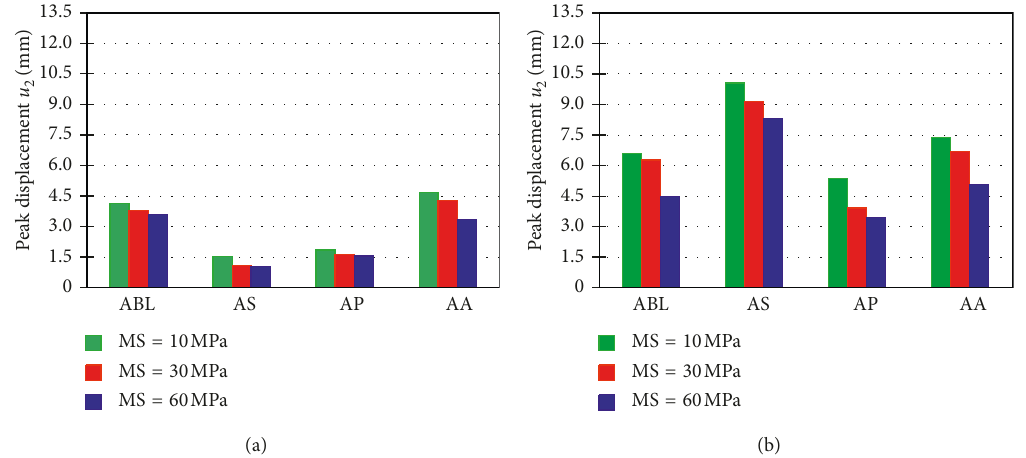
Figure 19: The effect of pebble layer compaction on peak horizontal displacement u